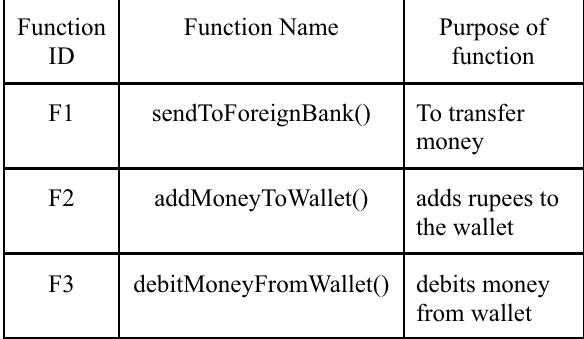
Table 2. List of smart contract